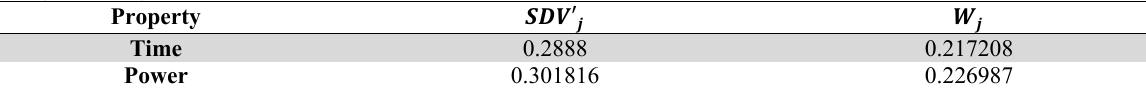
Weights assigned to criteria